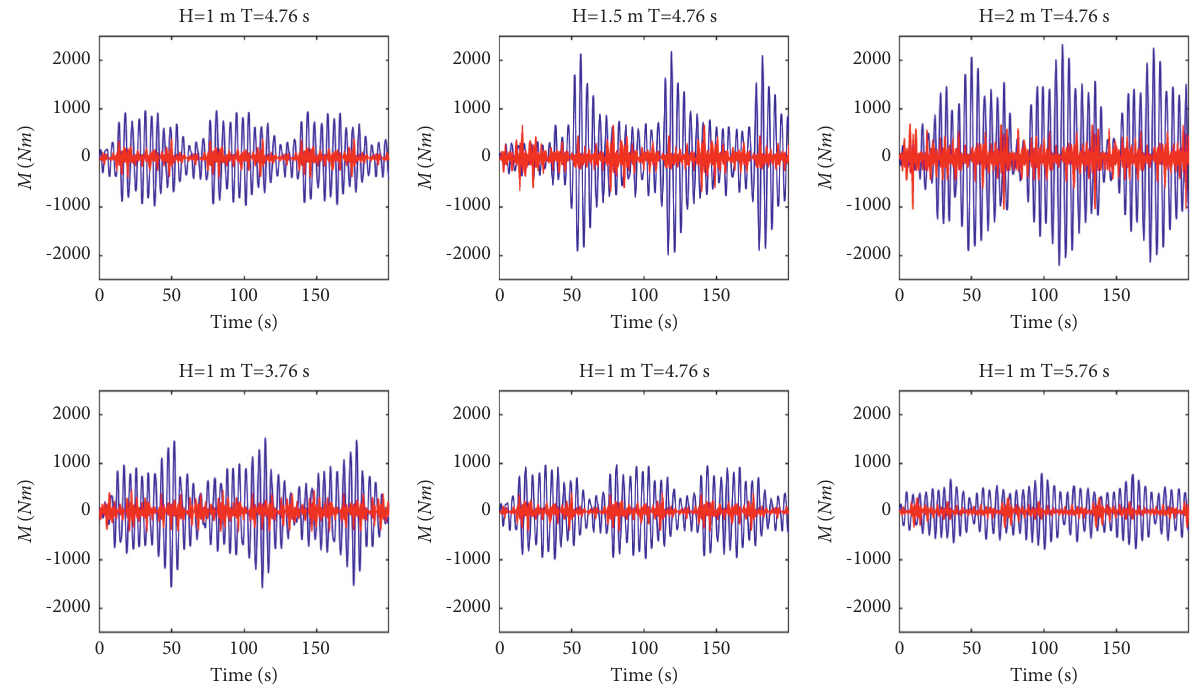
Figure 4: The control torque comparison of the gyroscopic system under the random wave circumstance using LQR and NMPC, re- spectively. The red curve represents the NMPC controller, and the blue curve represents the LQR